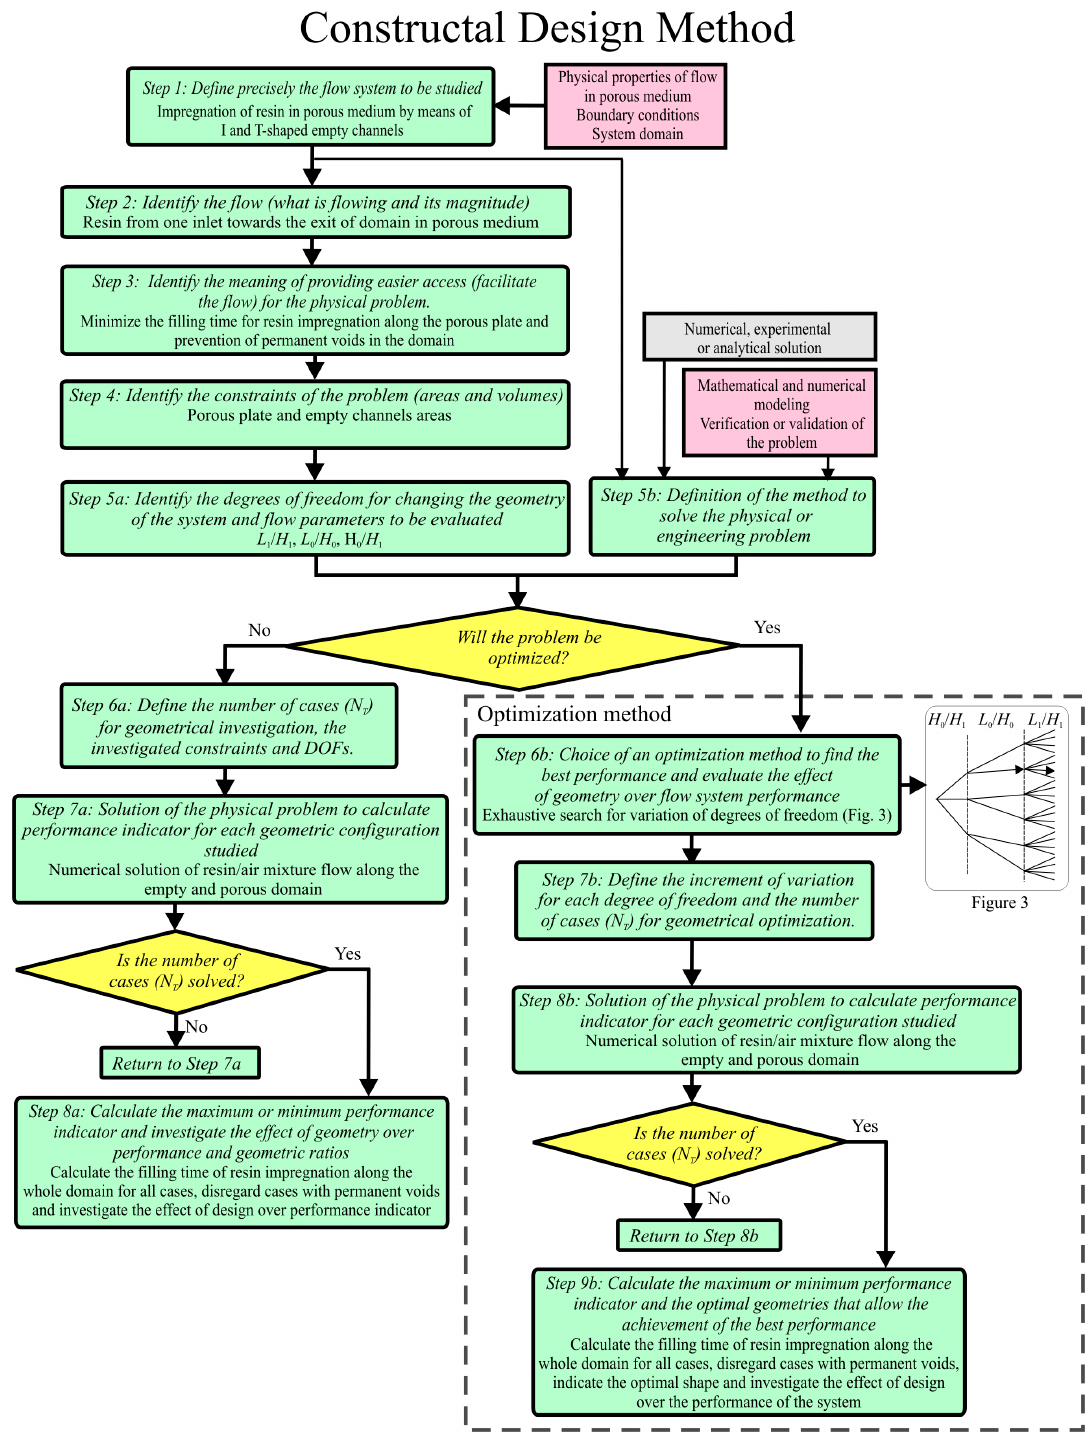
Figure 2. Flow chart illustrating the main steps of the geometrical optimization of I and T-shaped empty channels inserted into the rectangular porous plate for resin impregnation along the domain.